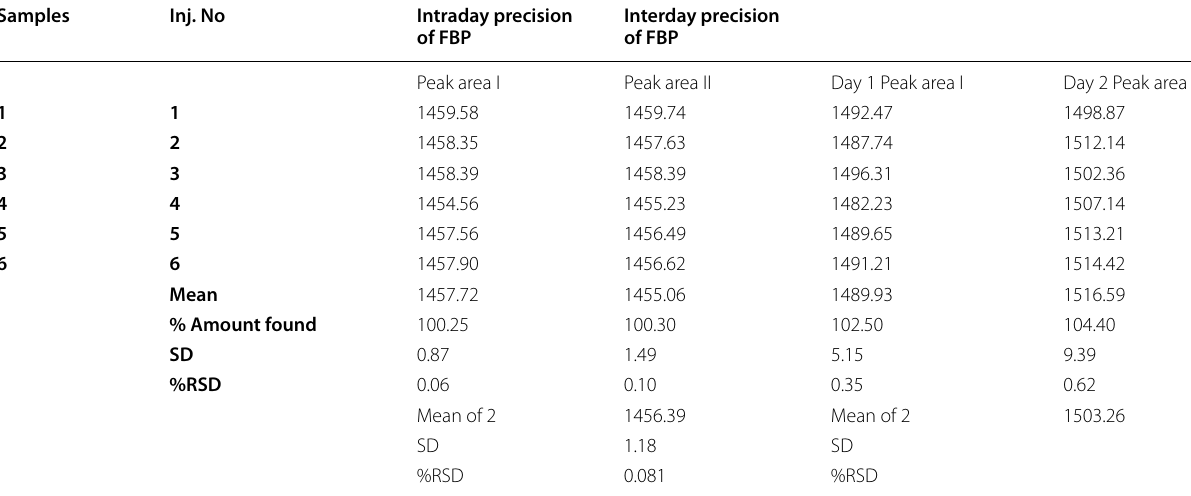
Table 9 Intra- and inter-day precision ( n